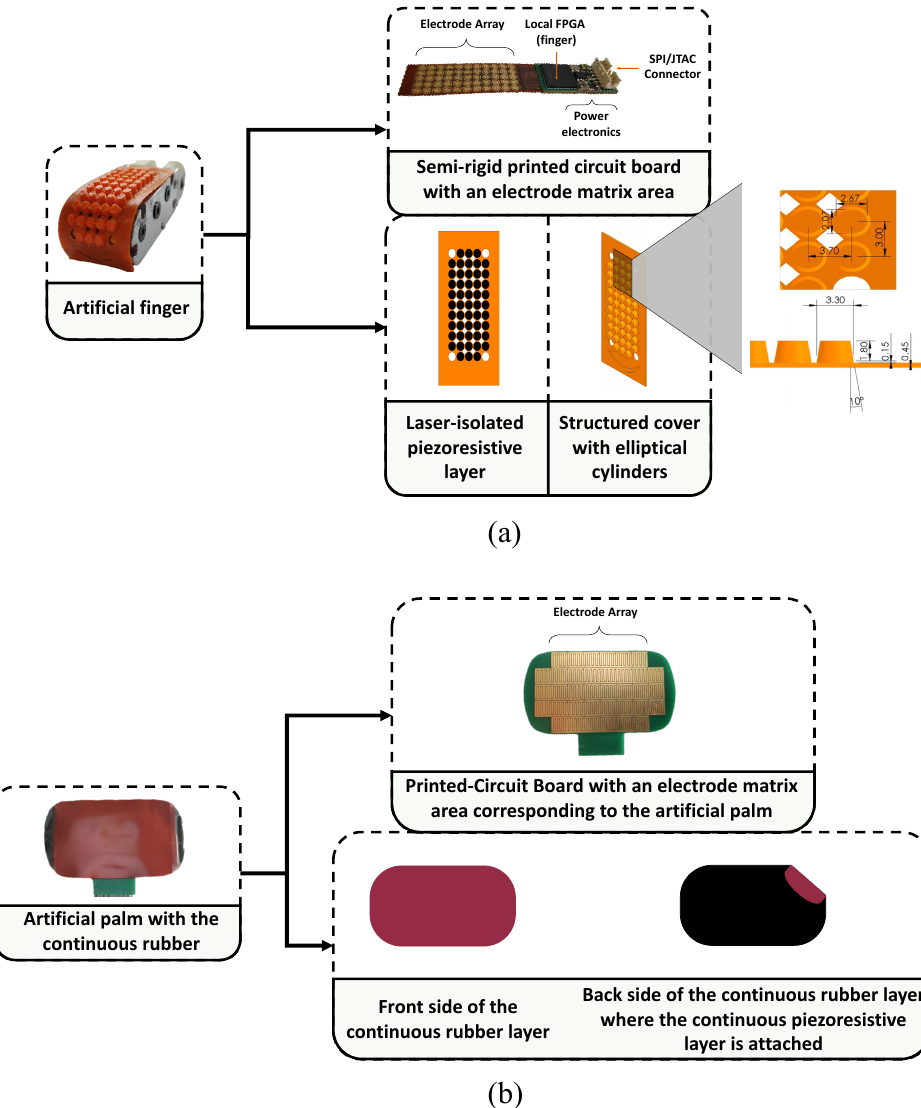
Figure 2. ( a ) The artificial finger is made of a semi-rigid printed circuit board, with a structured cover that helps to concentrate the force on the taxels (force sensing units in the tactile array). ( b ) Artificial palm with continuous cover. Dimensions are given in